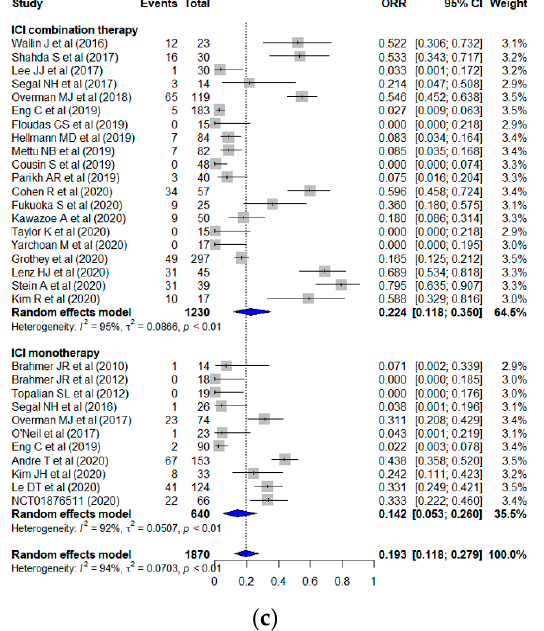
Figure 3. Forest plots displaying the pooled ORR according to ( a ) treatment line, ( b ) microsatellite phenotype, and ( c ) drug regimen. The blue quadrilaterial indicates the pooled incidence and its 95% confidence interval.